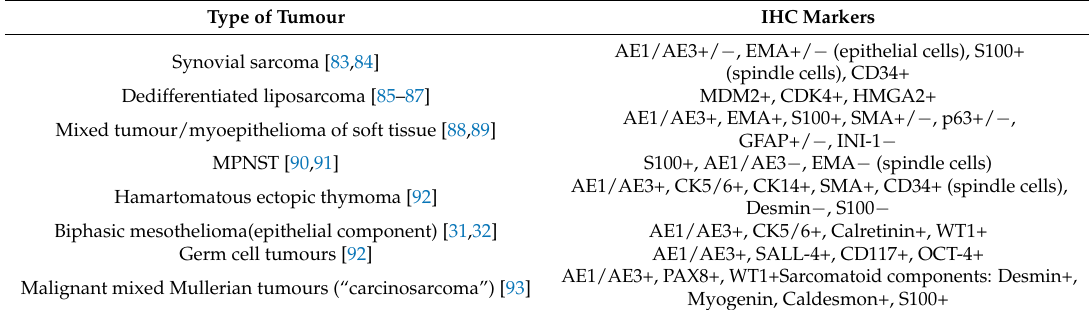
Table 6. Tumour-specific markers useful for the diagnosis of various biphasic connective tumours. Type of Tumour IHC Markers AE1/AE3+/ − , EMA+/ − (epithelial cells), S100+ Synovial sarcoma [83,84] (spindle cells), CD34+ Dedifferentiated liposarcoma [85–87] MDM2+, CDK4+, HMGA2+ Mixed tumour/myoepithelioma of soft tissue